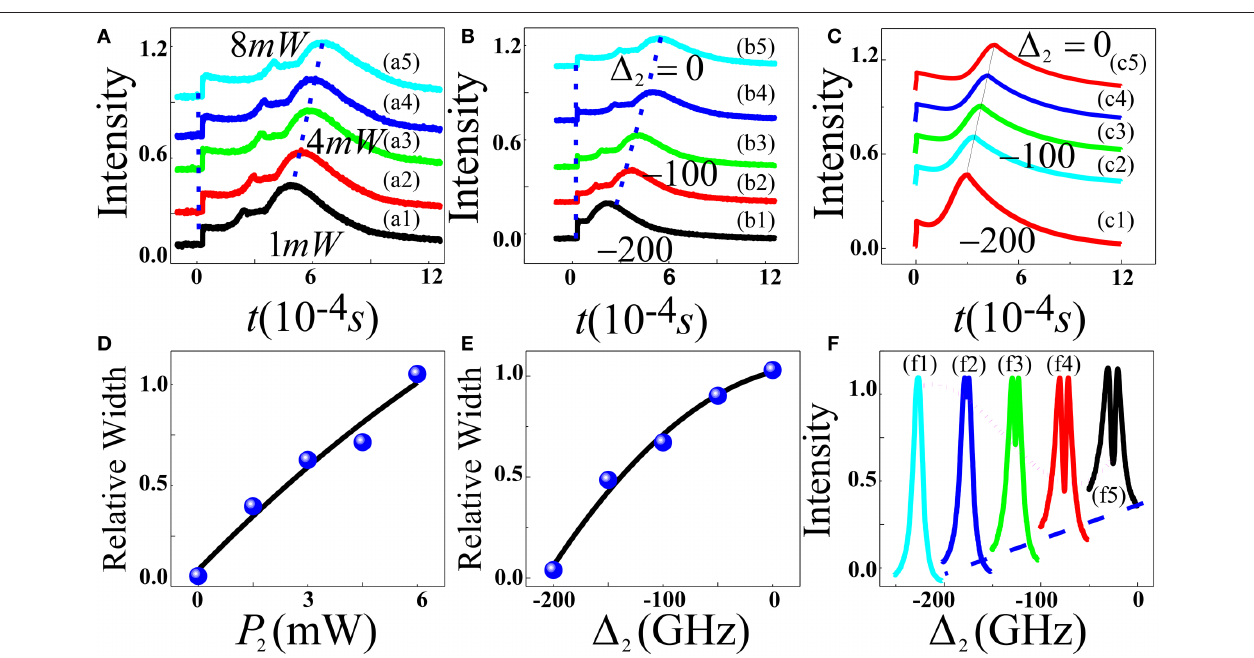
FIGURE 3 | (A,B) are V-type system intensity of the composite FL signal at 1 2 = 0 in the time domain. (a1–5) by changing E b power from 1, 2, 4, 6mW, and then to 8 mW, respectively, while scanning E a . (B) similar as (A) but changing E b detuning from − 200, − 150, − 100, − 50, and 0GHz, respectively. (C) Theoretical prediction corresponding to (B) . (D,E) Share same scale are relative AT-splitting distance corresponding to (A,B) , respectively. (F) Similar as (B) but showing FL spectral